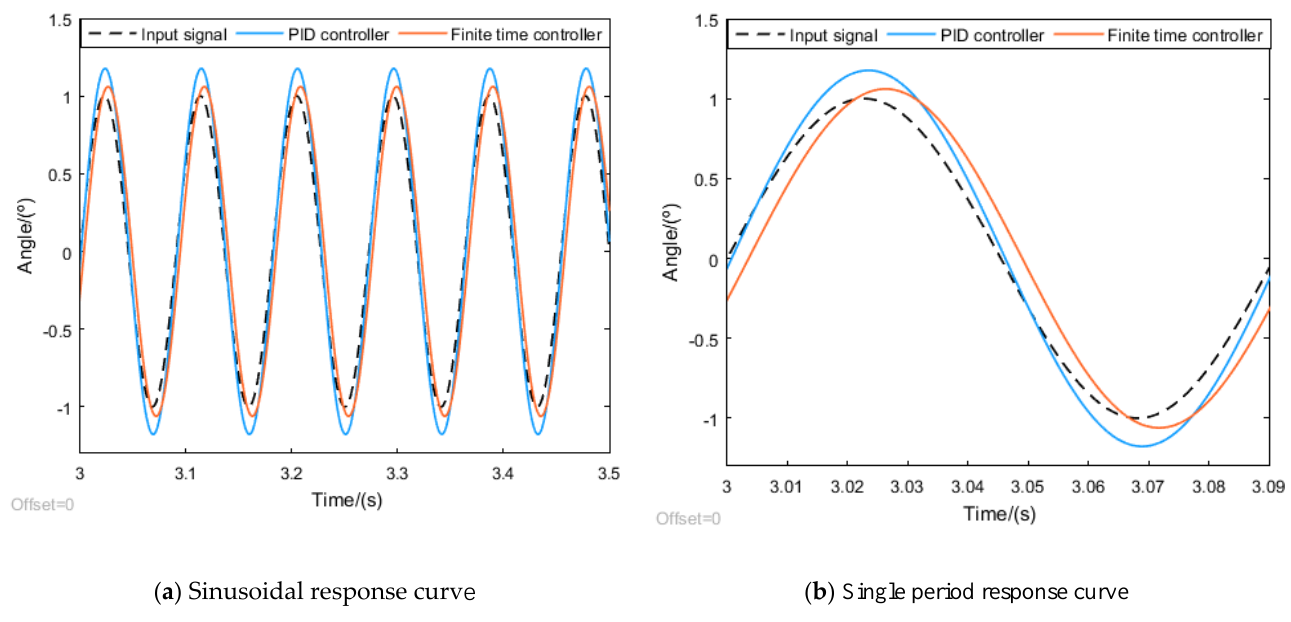
Figure 9. Finite-time composite control response curve of the motor system with 10 Hz and 1°sinus- oidal signal.